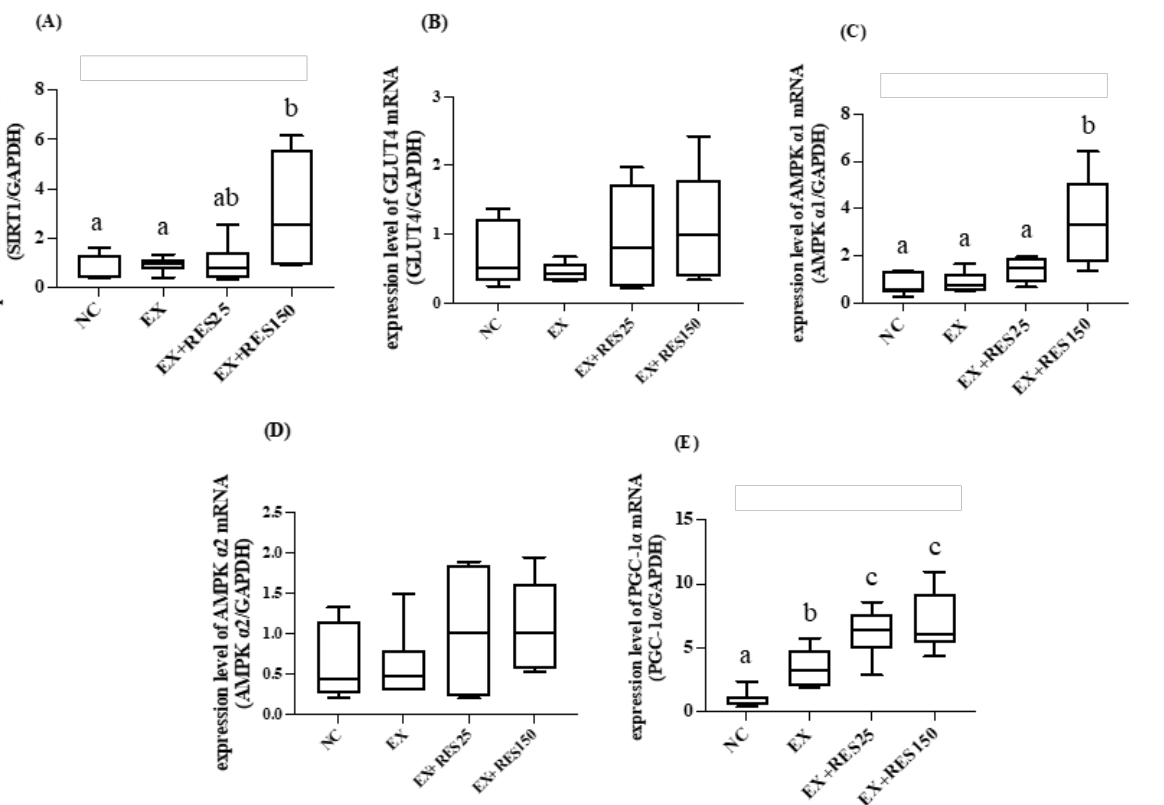
Figure 6. Effects of resveratrol on energy utilization and antioxidative mRNA expression in tibialis anterior muscle during short-duration downhill running training. ( A ) Sirt1 mRNA ( B ) Ampkα1 mRNA ( C ) Ampkα2 mRNA ( D ) Glut4 mRNA ( E ) Pgc1α mRNA. mRNA expression was normalized